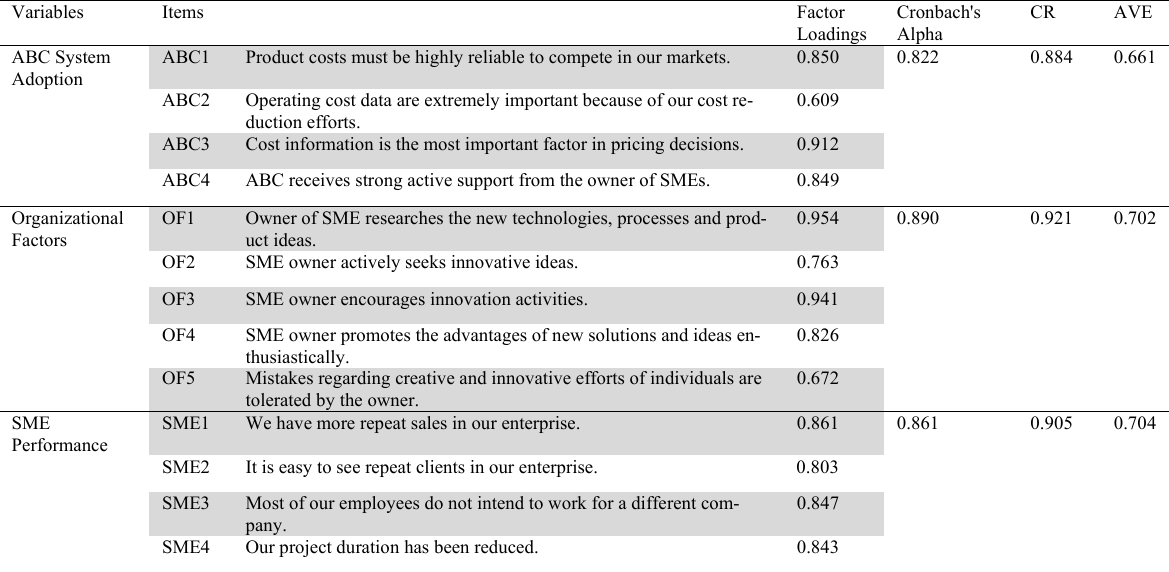
Items, Factor Loadings, CR and